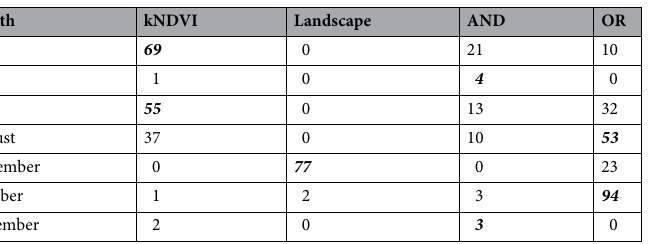
Table 3. Predictive ability of the simulation results. The number that the model considered as “correct” and showed the lowest AIC among 4 models was shown. In total, 100 runs were conducted for each simulation, but some of the runs were not considered as “correct”, thus, the total number was not always 100. The best performance for each month is highlighted by bold italic text.